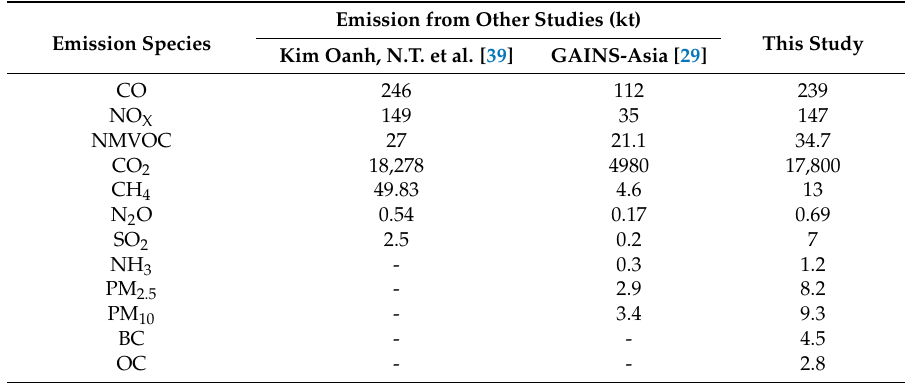
Table 4. Comparison of the emission inventory over the BMR area in the year 2010 between other studies and this